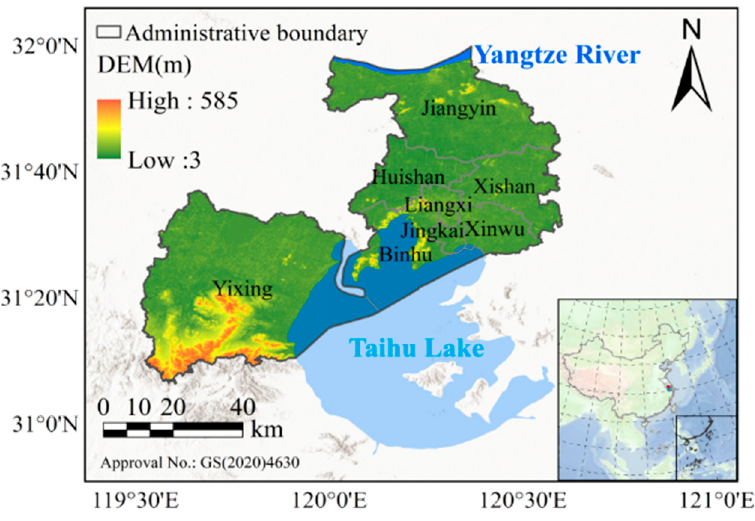
Figure 1. Location of the Wuxi area.